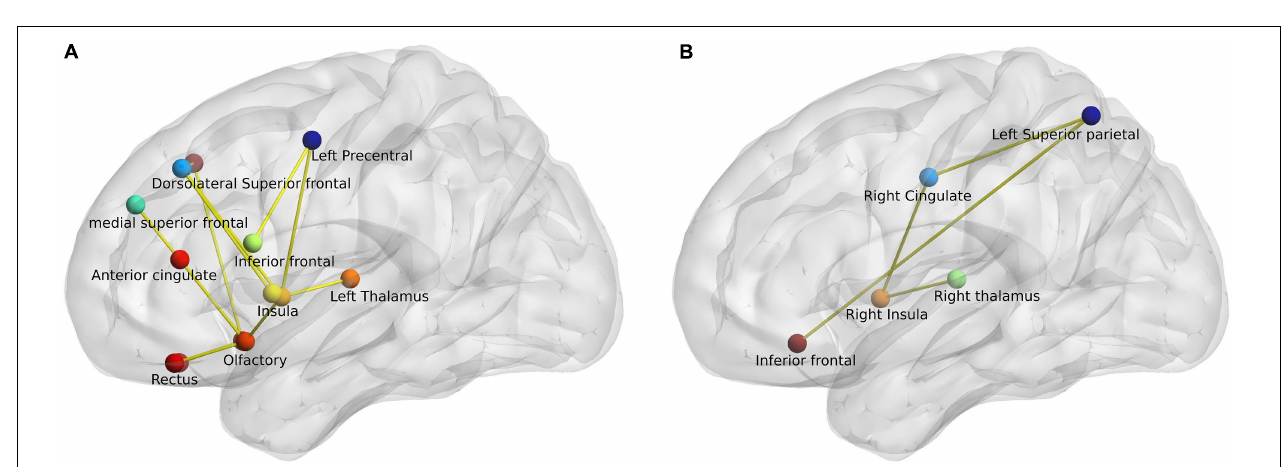
FIGURE 3 | Network-based statistic-derived subnetworks. (A) Left sagittal view shows the significant subnetwork obtained from the comparison between young healthy controls (HC Y ) and PD patients. (B) Left sagittal view shows the significant subnetwork obtained from the comparison between middle-aged healthy controls (HC M ) and PD patients. The circles represent the nodes and lines represent the edges or connections with a t -stat > 3 and p < 0.05